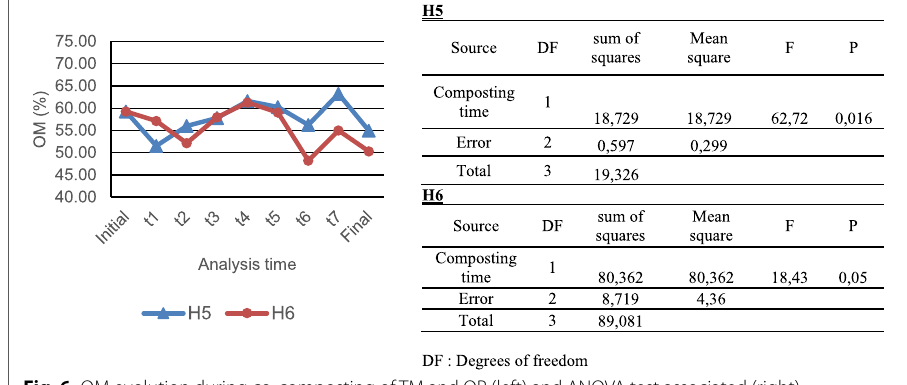
Table 9 ANOVA test associated with C/Ni and TF effects on OM Source DF ASS SSS F -value